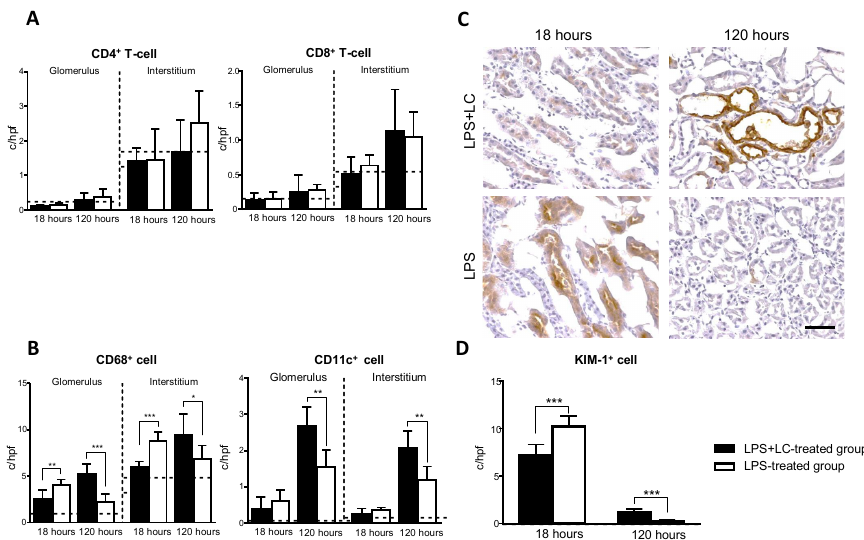
Figure 5. Effect of LC on T-cell and DC accumulation and KIM-1 expression in the glomerulus and interstitium after LPS injection. ( A , B ): At 18 and 120 h post-LPS injection, the numbers of CD4 + and CD8 + T cells and the numbers of CD68 + and CD11c + cells as macrophages and DCs (c/hpf) in the glomeruli and interstitia in the LPS + LC- and LPS-treated groups. ( C ): KIM-1 expression was detected in many tubules in the injured interstitium after LPS injection, localized to the apical side of the epithelium with some diffuse cytoplasmic staining (brown) ( × 400 magnification). ( D ): KIM-1 + cells were also counted and the numbers of positive cells in the LPS + LC- and LPS-treated groups were compared. Dotted lines: Mean values from the saline-injected group without LPS. The data are mean ± SEM. * p < 0.05, ** p < 0.01, *** p < 0.005, LPS + LC vs. LPS-treated group. KIM-1: kidney injury